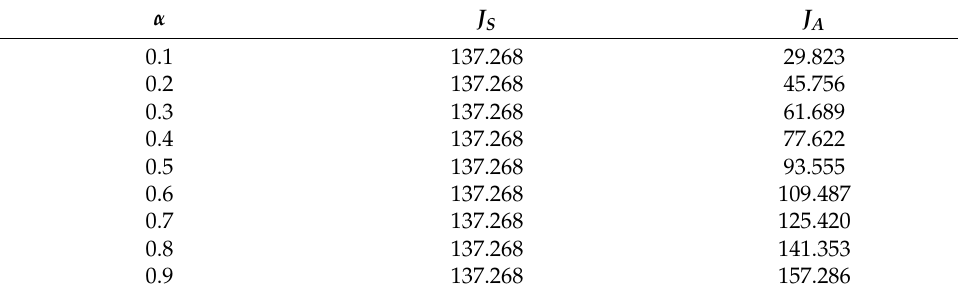
Table 1. Players’ payoffs for the chosen strategies C ij = 1, I ij = 1.